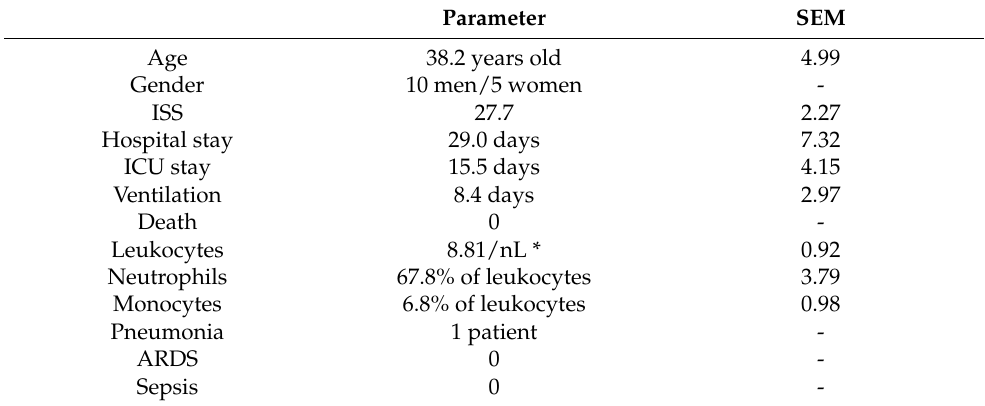
Table 1. Patient